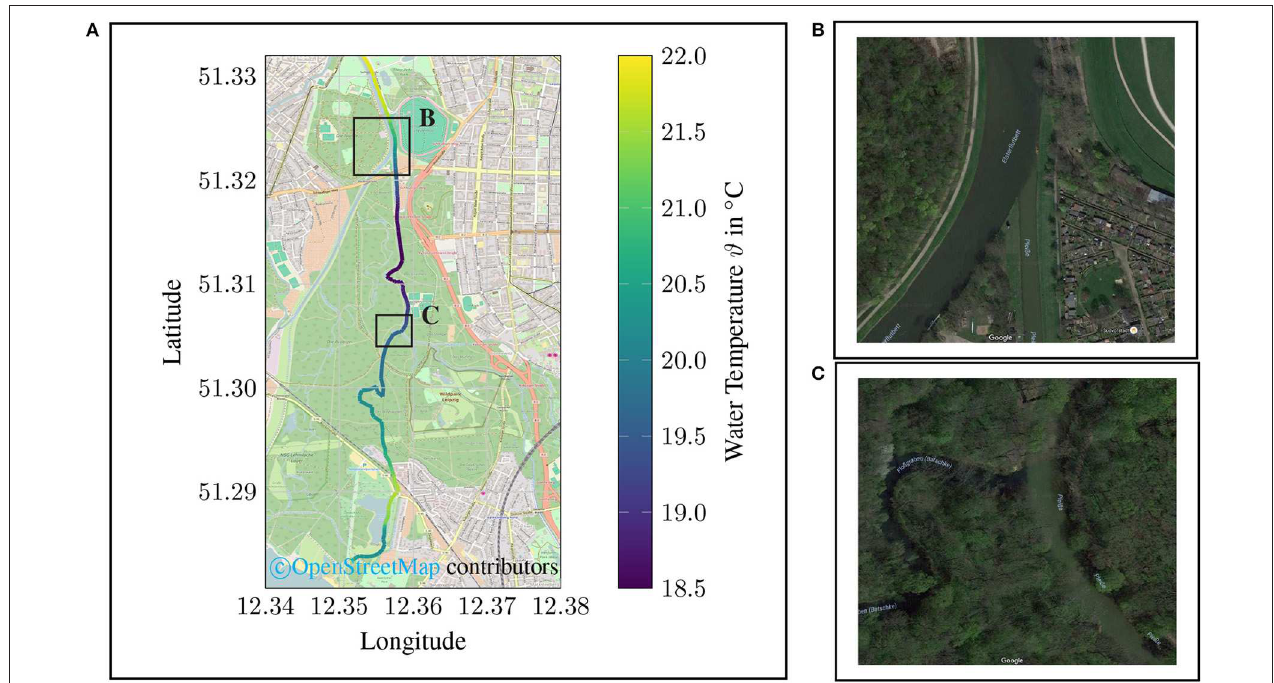
FIGURE 12 | Temperature data of mobile monitoring campaign along a river course (Elstermühlgraben, Pleiße, Elster) in the city area of Leipzig, Saxony, Germany (2016 August, 19). In (A) the spatial plot of the water temperature is given. Two squares are indicating points of special interest. (B) marks the estuary of the Elstermühlgraben into the Pleiße and (C) the estuary of the Pleiße into the Elster. ( B retrieved from https://goo.gl/maps/qQyVoWTnV4J2; C retrieved from https://goo.